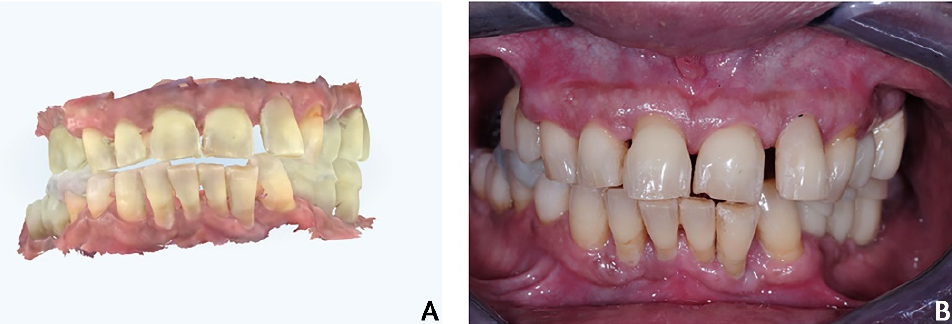
Figure 17. Case 3. Digital design of posterior bites (see the increment of vertical dimension and the anterior open-bite). ( A ) Intra-oral scans; ( B ) intra-oral photograph with cemented posterior multiple bites.